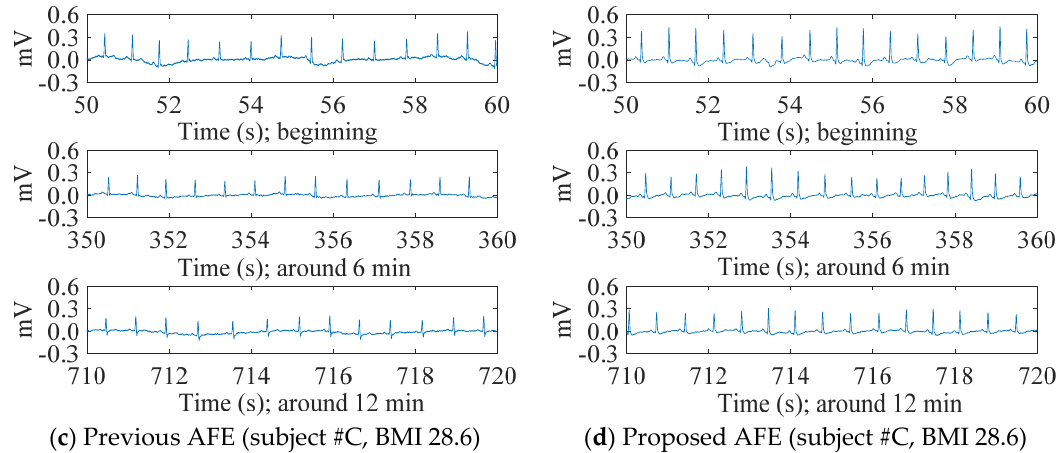
Figure 6. The transition of cECG recordings measured through thick clothing (1.70 mm) in low-humidity environments. The previous AFE was used for the recordings of ( a , c ), whereas the proposed AFE was used for the recordings of ( b , d ). Both recordings ( a , b ) were measured from a healthy-weight-BMI subject (22.0, #A), and recordings ( c , d ) were from an overweight-BMI subject (28.6, #C).